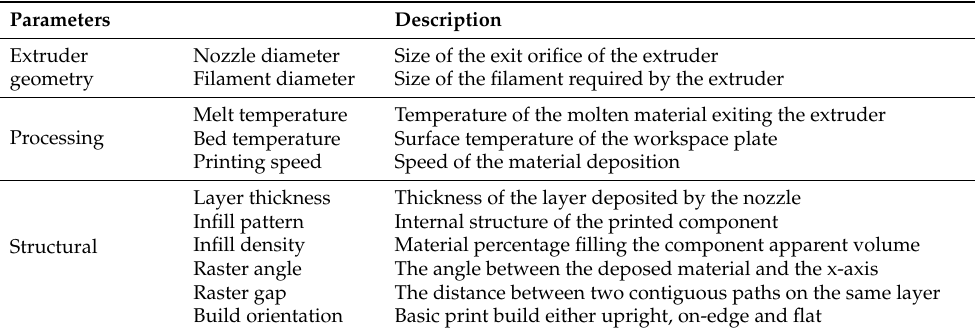
Table 1. Definitions of fundamental printing parameters for FDM